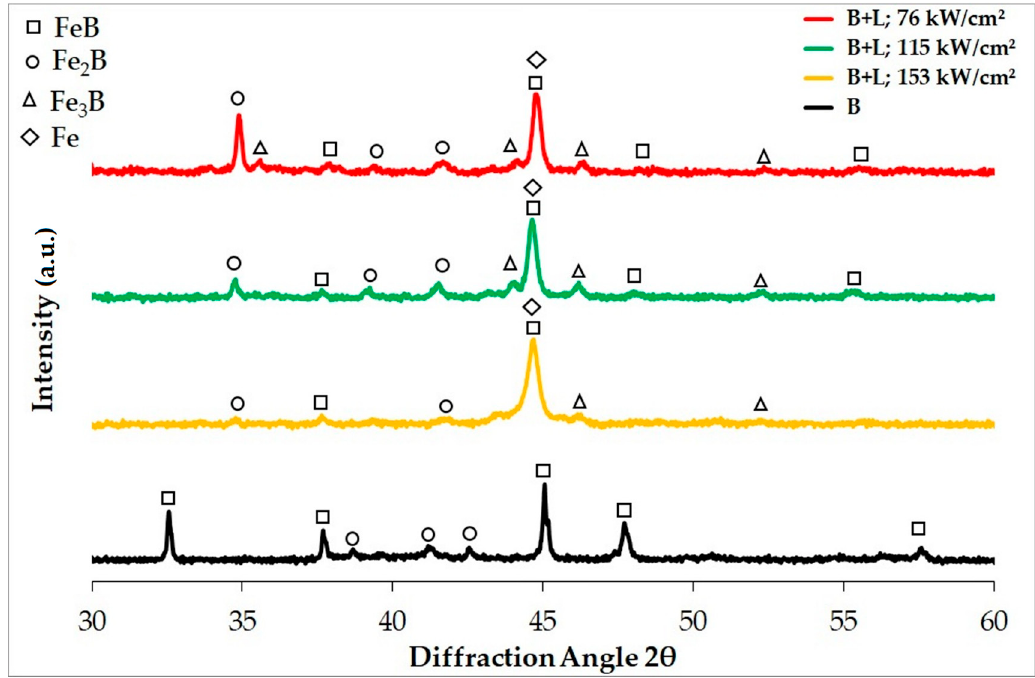
Figure 4. X-di ff raction pattern of di ff usion boronized layer produced on CT90 tool steel before and Figure 4. X-diffraction pattern of diffusion boronized layer produced on CT90 tool steel before and after laser after laser processing.